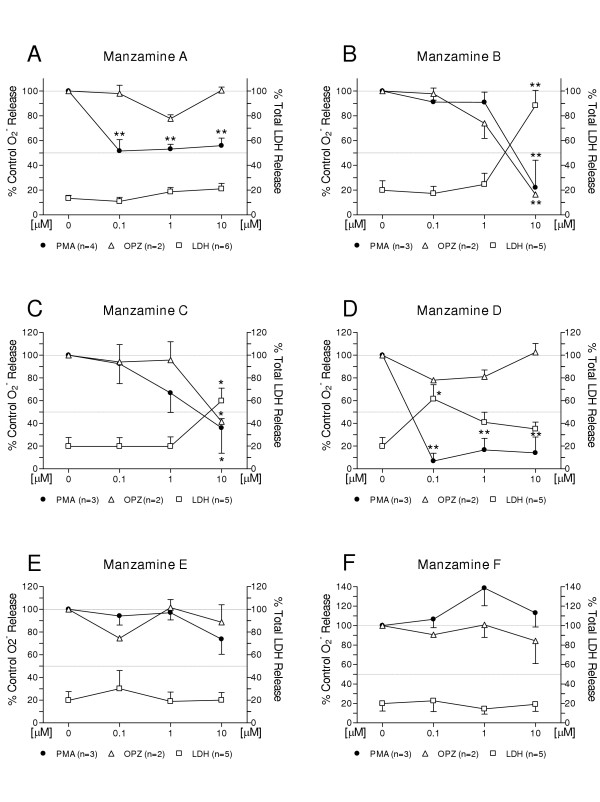
Differential effects of manzamines A, B, C, D, E and F on PMA and OPZ-stimulated O2- generation by LPS-activated rat neonatal microglia. Rat neonatal microglia (200,000 cells/well) were activated with LPS (0.3 ng/mL) for 17 hours. Manzamines were added 15 min before stimulation with either PMA (1 μM) or OPZ (0.5 mg/mL). After 70 min, agonist-triggered O2- release was determined as described in Materials and Methods. LDH release, indicator of cytotoxicity, was measured as described in Materials and Methods. Data are expressed as percentage of control O2- release triggered by PMA (MZA: 13.8 ± 1.9 nmoles O2-/70 min; MZB, C, D, E, F: 10.8 ± 0.6 nmoles O2-/70 min), or OPZ (9.4 ± 0.7 nmoles O2- /70 min). Data show mean ± SEM of indicated number (n) of experiments. * P < 0.05, ** P < 0.01.